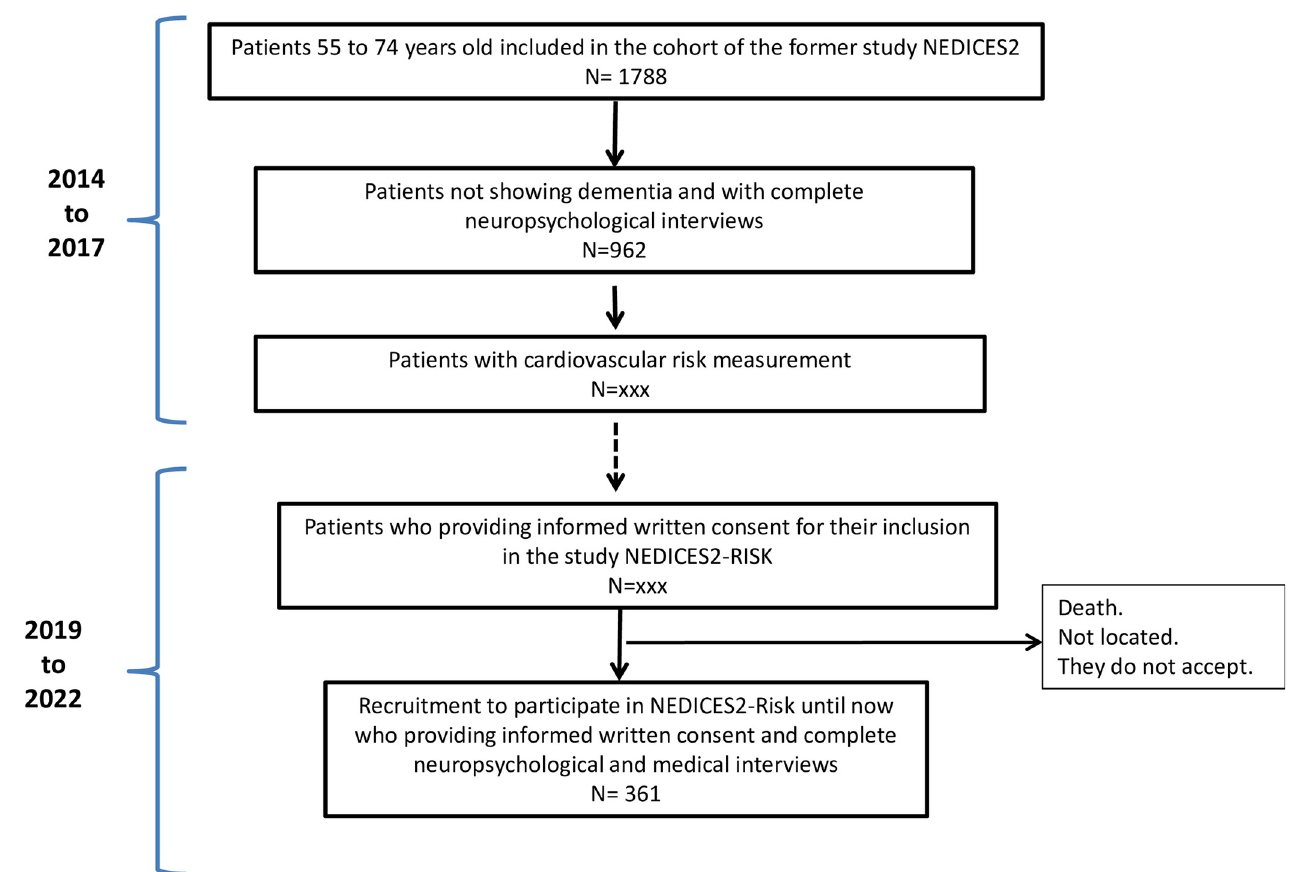
Fig 1. Flow chart of the study with the number of subjects